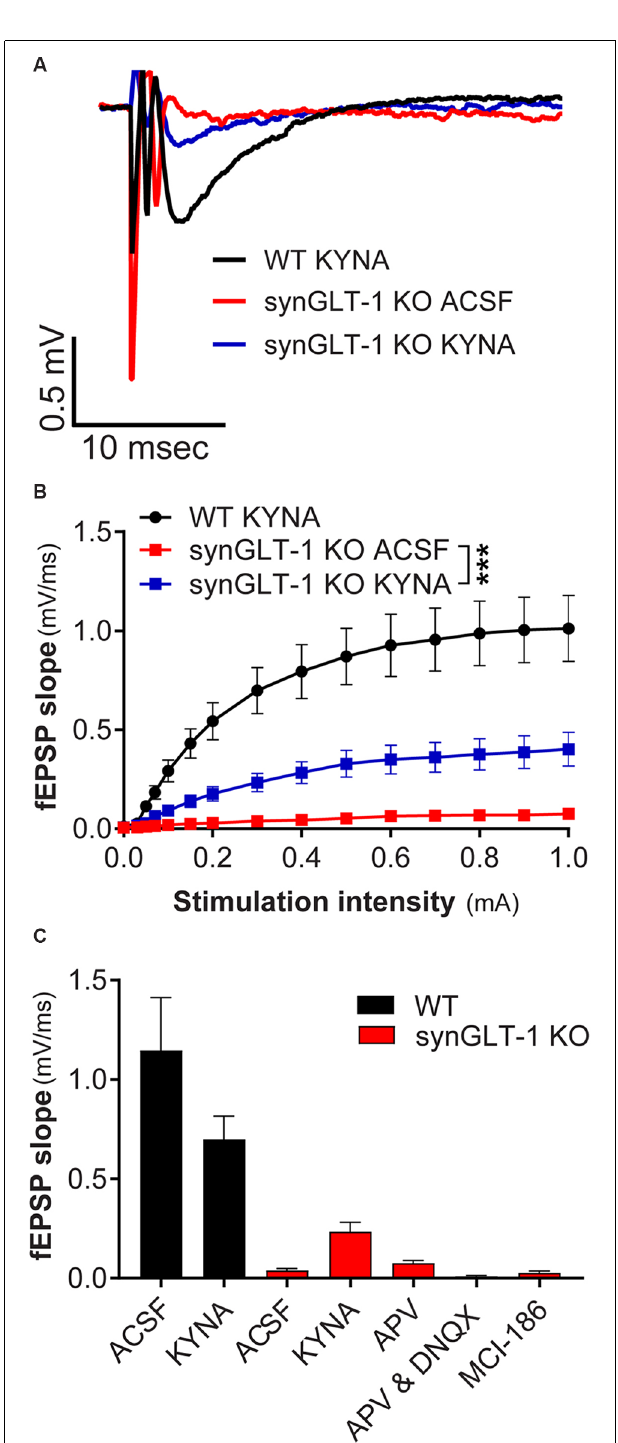
FIGURE 5 | Kynurenic acid partially restored excitatory synaptic transmission in synGLT-1 KO mice. (A) Representative field potentials recorded in the stratum radiatum of CA1 hippocampal slices in response to a single electrical stimulus of 0.3 mA applied to the Schaeffer collateral/commissural fibers in 20 weeks old WT littermate controls with 3 mM kynurenic acid treatment (black trace), synGLT-1 KO (red trace) and